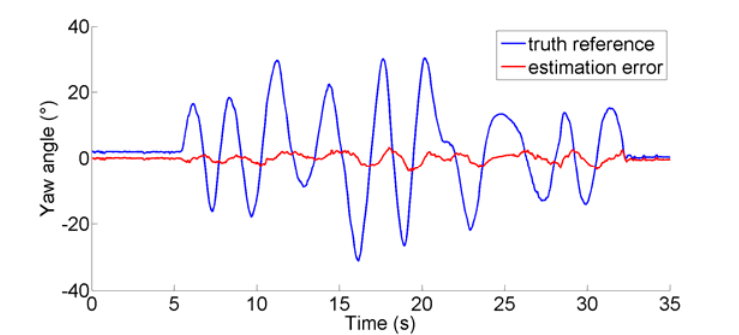
Figure 9. Yaw angle time functions, truth reference and estimation error by the